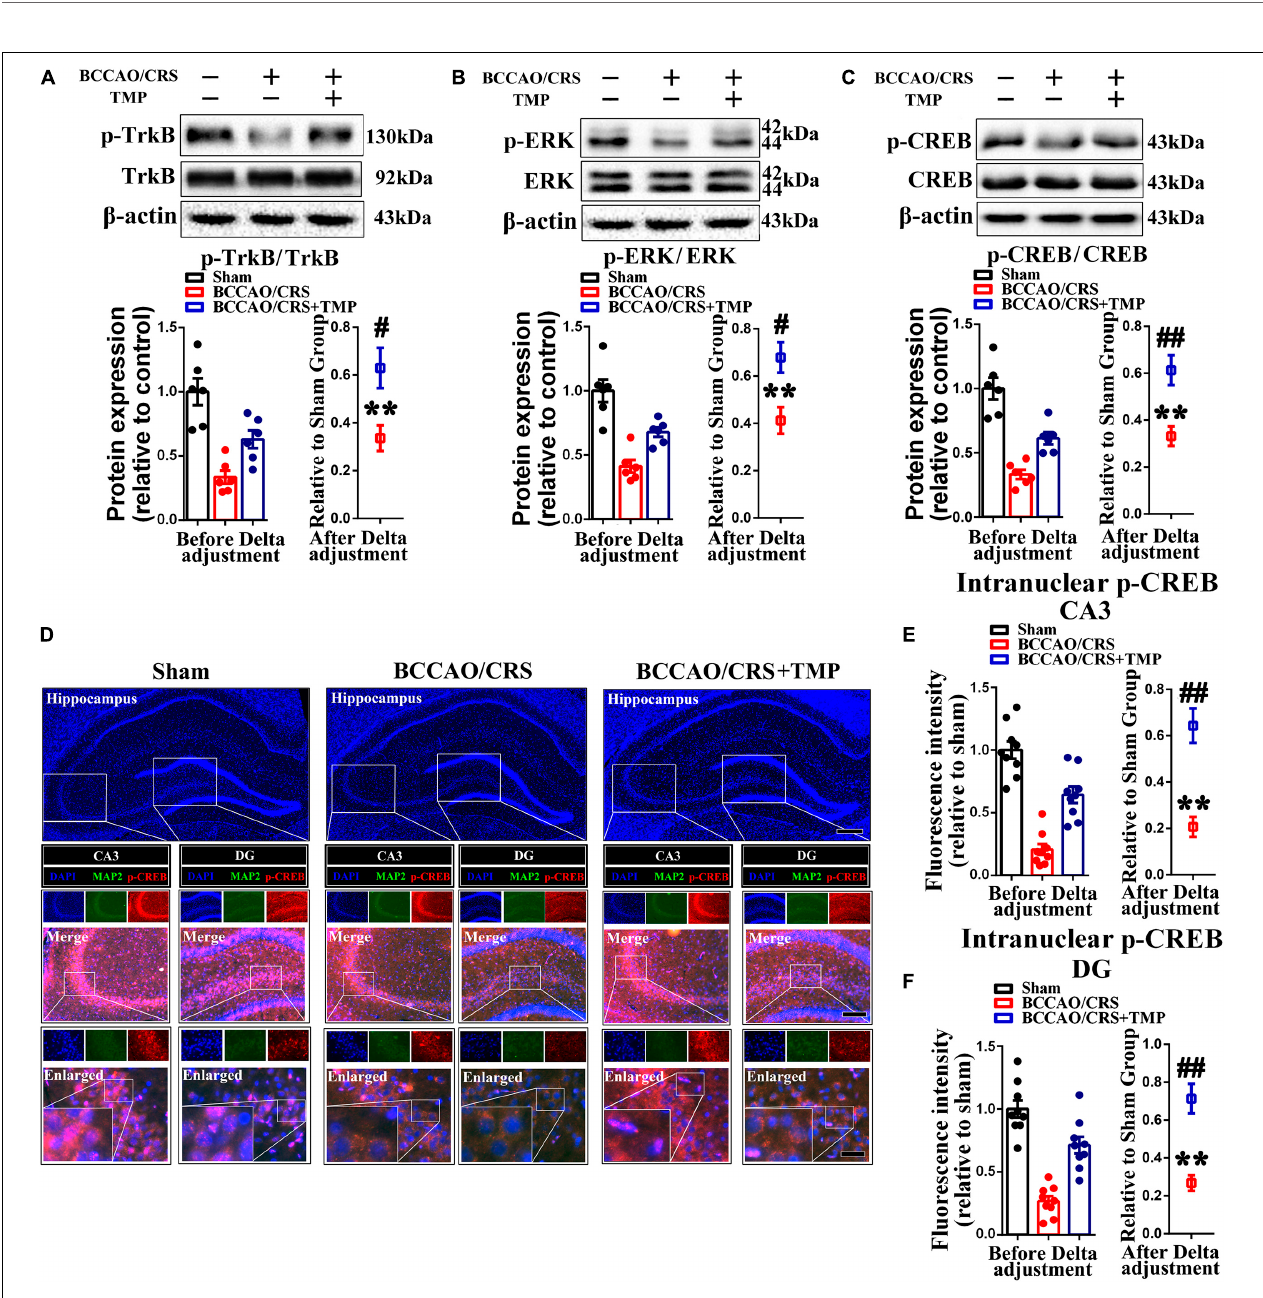
FIGURE 8 | TMP activates TrkB/ERK/CREB signaling pathway to exert neuroprotective effect in BCCAO/CRS rats. (A–C) Typical immunoblots exhibiting the expression and semi-quantitative analysis of proteins related to TrkB/ERK/CREB signaling pathway including p-TrkB (A) , p-ERK (B) and p-CREB (C) . (D) Representative immunostaining depicting the colocalization of MAP2 (green) and CREB (red) in hippocampus of CA3 and DG. The inserts were high magnification from each group. Nuclei were counterstained with DAPI. Scale bar: Scale bar: 400 µ m; 200 µ m for medial inserts, and 50 µ m for enlarged inserts. (E) Quantification of the optic intensity of intranuclear CREB in hippocampal CA3and DG. (F) Bar chart summarizing the optic intensity of intranuclear p-CREB in hippocampal CA3 and DG. ** P < 0.01 vs. Sham. # P < 0.05, ## P < 0.01 vs. BCCAO/CRS. Data are presented as mean ± SE. n = 6 per group for Western blotting; n = 3 in each group and 3 slices per rat for